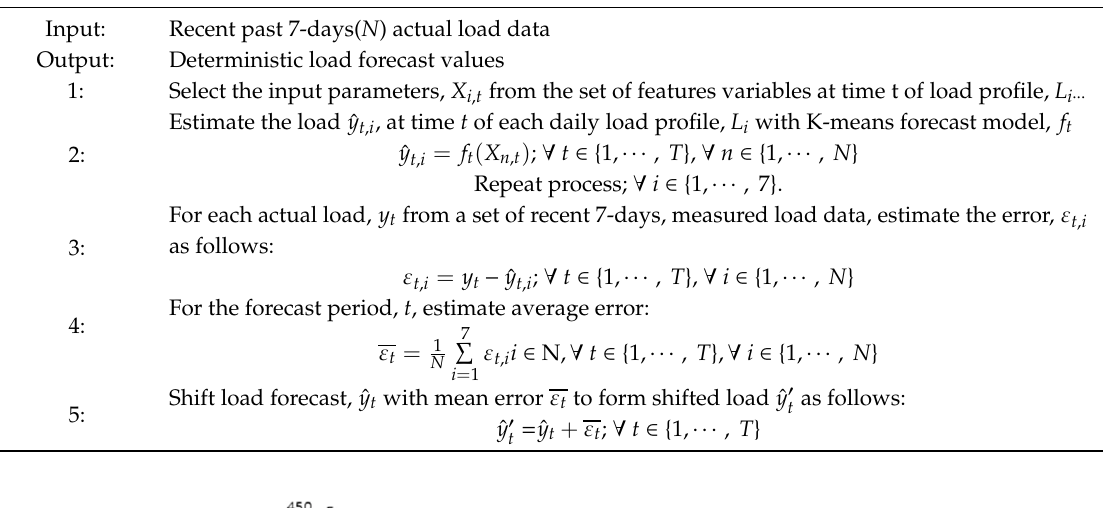
Algorithm 2: Variance Error Correction Model.